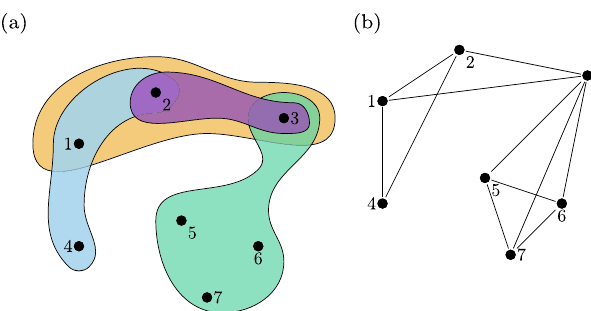
Fig. 1 Graphs and hypergraphs. Example of a hypergraph ( a ) and its projection to a dyadic graph ( b ). Coloured areas represent different hyperedges. In the hypergraph, the degree of node 4 is d 4 = 1, since it is the only member of one hyperedge, the degree of node 2 is d 2 = 3 since it is a member of